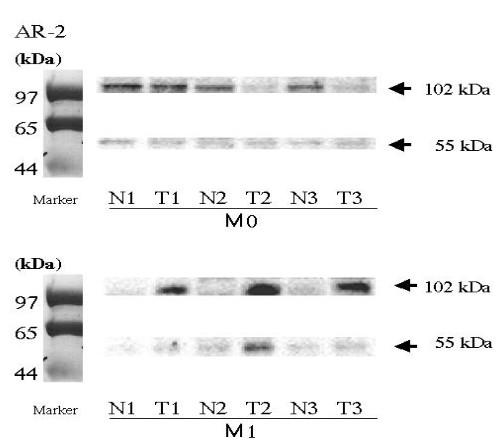
Western blotting analyses of IFNAR2 proteins in primary lesions with (M1) and without (M0) metastasis. IFNAR2b; 55KDa, IFNAR2c; 102 KDa. N; non-tumor, T; tumor. Each number corresponds to a case number.